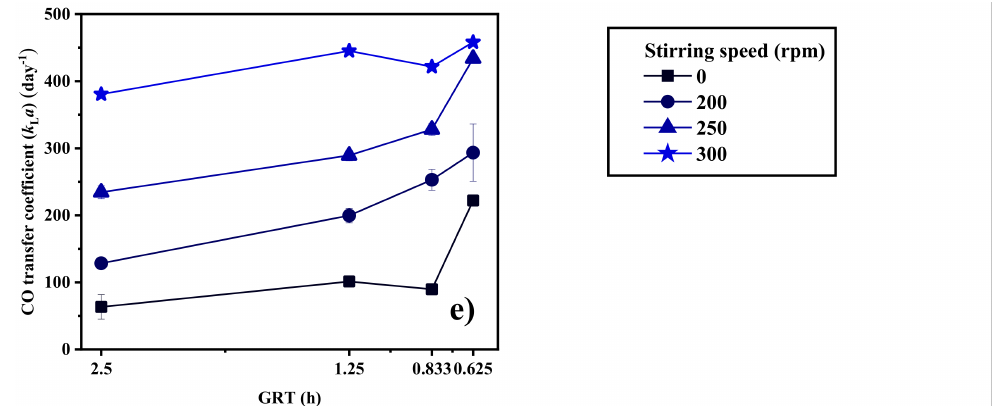
Figure 4. ( a ) CH 4 productivity, ( b ) electron yield to CH 4 , conversion efficiency of ( c ) H 2 and ( d ) CO, and ( e ) CO transfer coefficient ( k L a ) of the CSTR at different